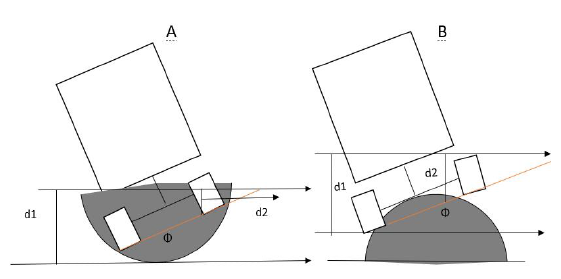
Figure 2. “A”: autonomous car runs into a pit; “B”: autonomous vehicle runs over an